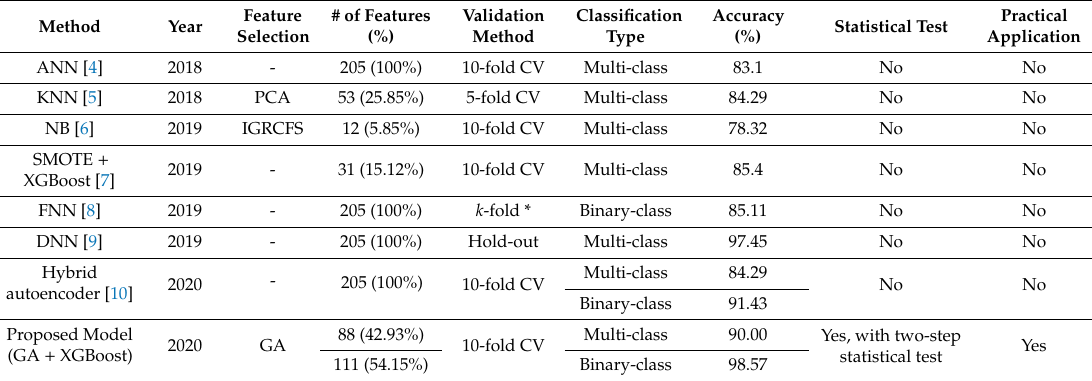
Table 11. Comparison of the proposed model with the results from previous related